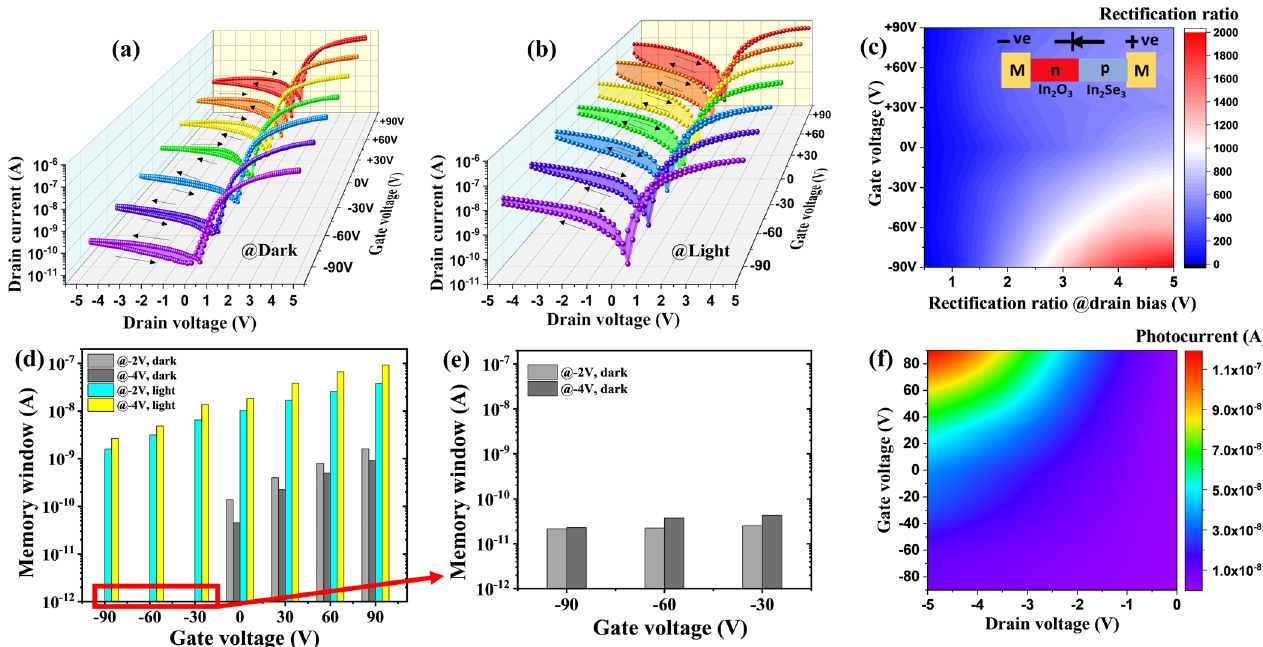
Fig. 2 In-plane memory and photodetection characteristics of FeS-HJ FET. Gate-dependent dual-sweep current-voltage behavior under ( a ) dark and ( b ) illumination conditions. Distinct memory windows are observed in reverse-bias conditions. c 2D contour map of the diode recti fi cation ratios for different drain and gate-bias voltages, calculated from the I – V curves with single sweep mode in ( a ). Inset shows the symbolic diode direction and marked the analogous p – n side with the respective materials. d Extracted memory windows ( I D-LRS – I D-HRS ) for two drain voltages exhibiting monotonous increase with gate-bias voltage under illumination. Negative memory window is observed for negative gate-bias voltages at dark (absent in semi-log plot). Absolute values are presented with semi-log scale in ( e ). f 2D contour map exhibits the photocurrent distribution for different drain and gate-bias